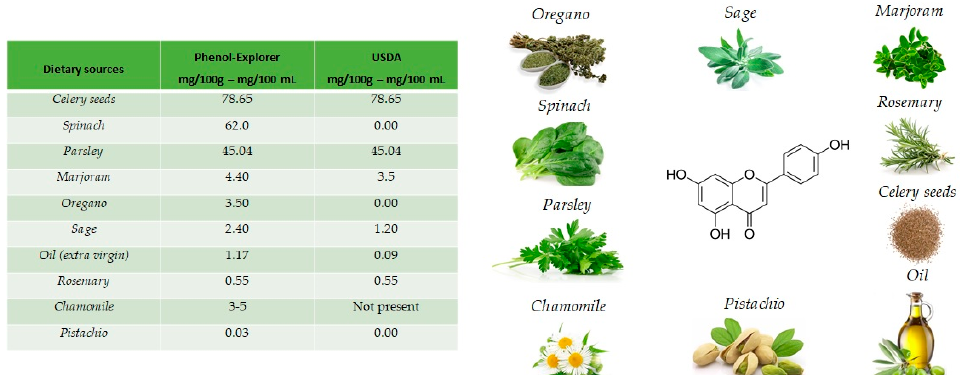
Figure 2. Main foods that contain apigenin, according to the database Phenol-Explore (http://phenol- explorer.eu/ accessed on 29 January 2021) and USDA Database for the flavonoid content of selected foods (https://www.ars.usda.gov/ accessed on 13 February 2021).